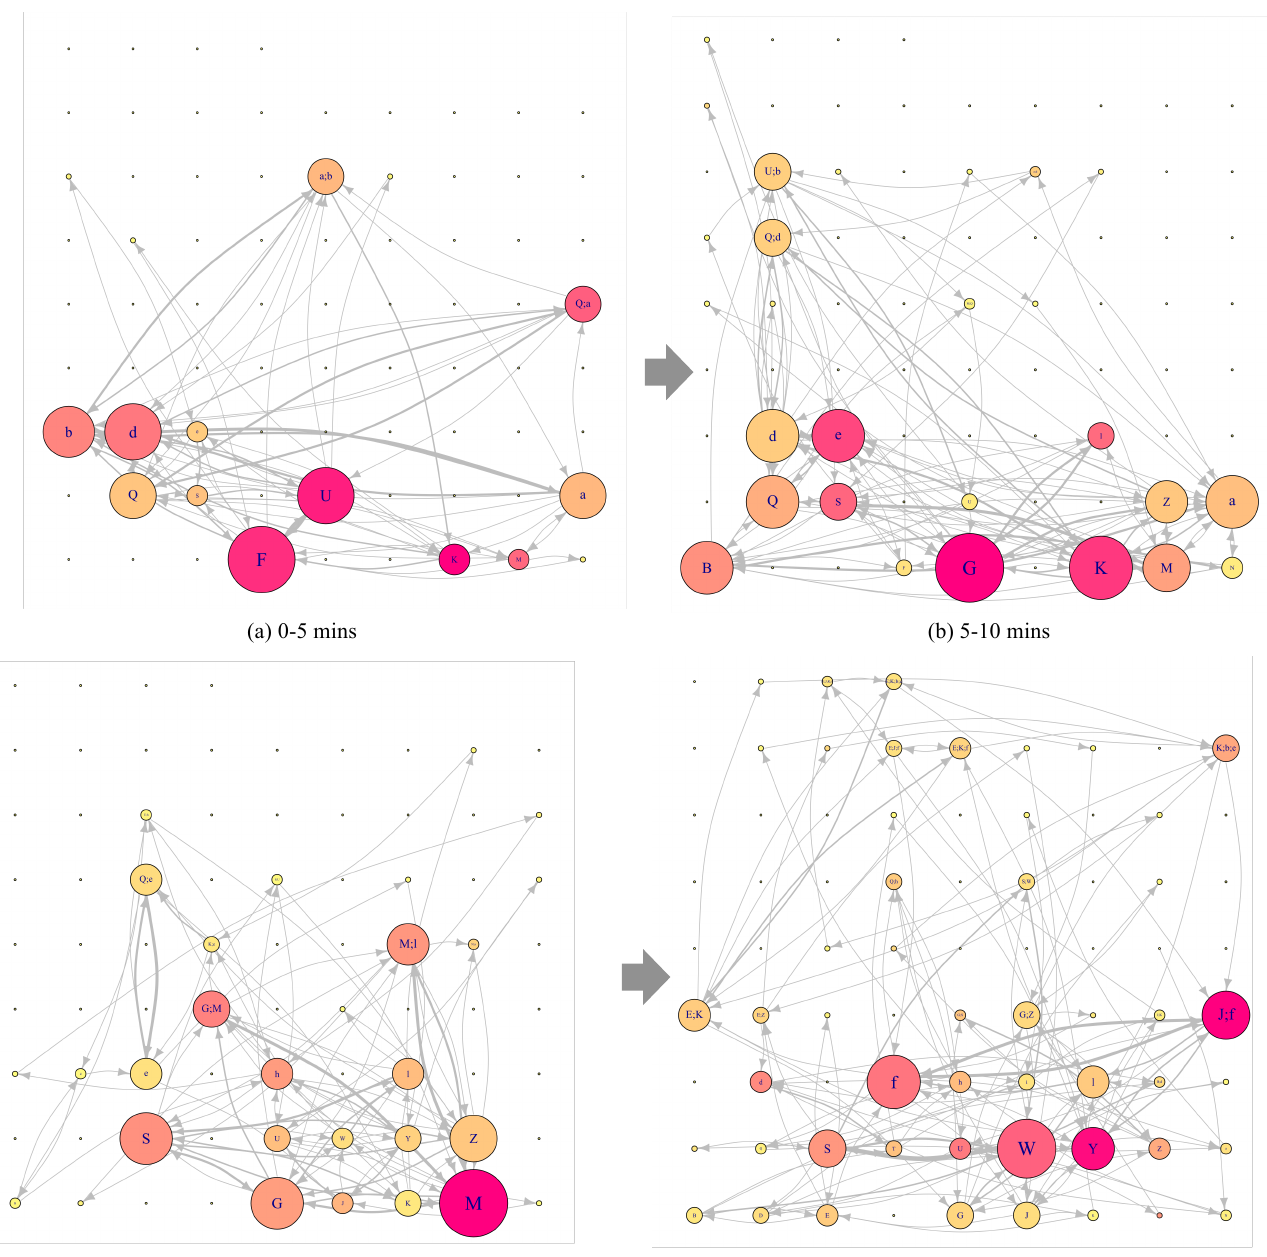
Figure 8. DNet visualisation of the EM data of one ATCS for the simulated enroute air traffic scenario. The figure shows the important AOIs in terms of EF numbers and EF duration for all the four time intervals. It also shows how the importance of various AOIs changes as we move across various time intervals. The relative location of each of the AOIs remains constant across all the static networks associated with different time intervals. For example, AOI K is placed at the bottom row sixth column for all the constituent static